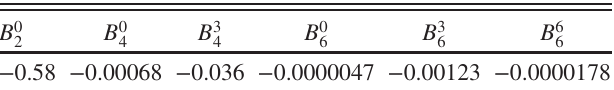
TABLE I. CEF parameters B m The units are in meV.